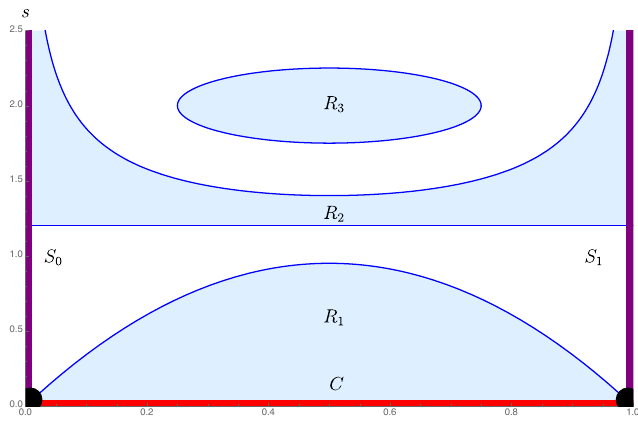
Figure 1. For an example of a generic observable the phase space can be constrained to several representative regions (blue). The collinear singularity C (red line), soft singularities S 0 and S 1 (purple lines), and soft-collinear singularities (black dots) are